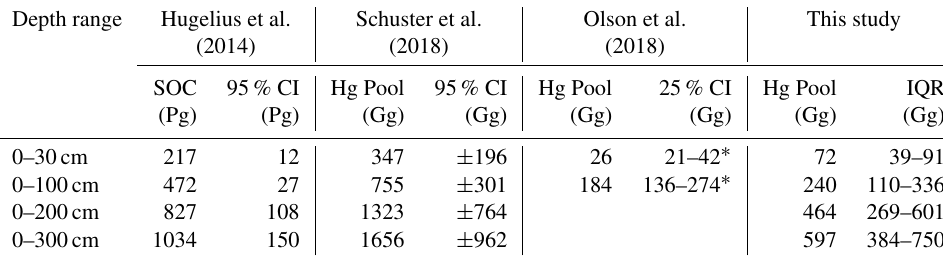
Table 3. Comparison of estimated pan-Arctic permafrost soil Hg pools by different studies. Depth range